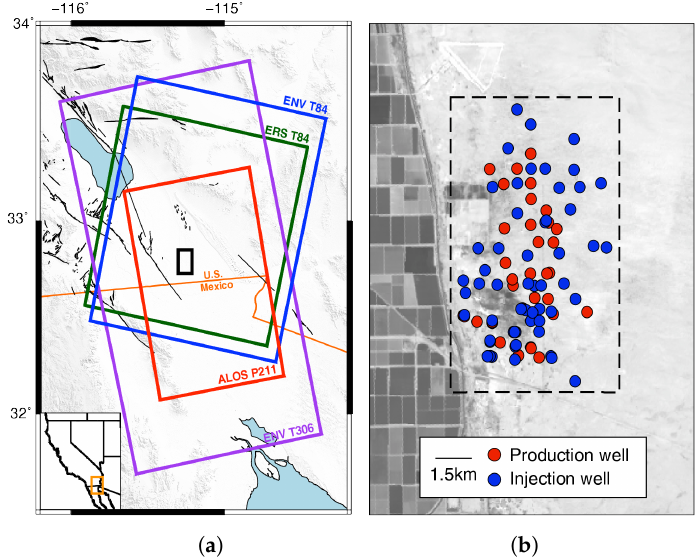
Figure 5. ( a ) Geographic setting of the East Mesa Geothermal Field (EMGF) study region and data coverage. Colored boxes indicate the extent of InSAR data used (Table 1) in this study, and solid black lines are Holocene faults. The black box indicates the area shown in ( b ) which shows the locations of currently active production and injection wells at the EMGF. The dashed black box is the reference box for Figures 7 and